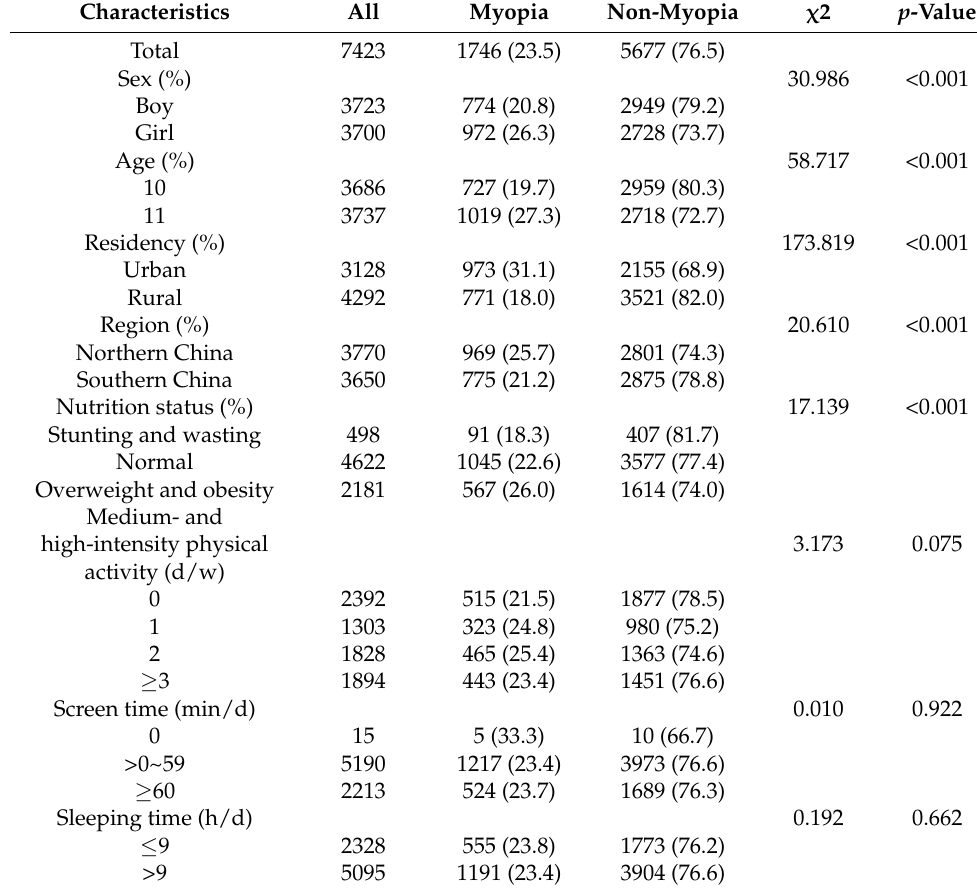
Table 1. Distribution of demographic characteristics across categories of myopia. Characteristics